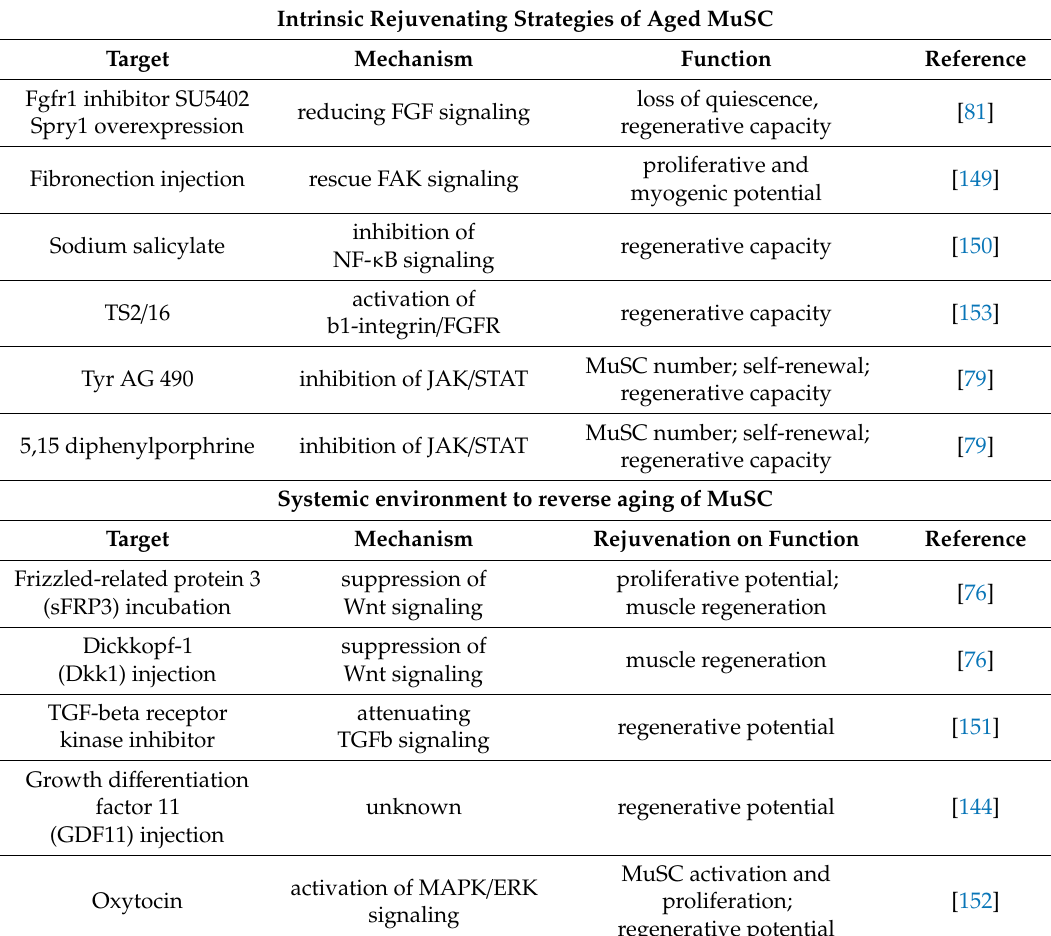
Table 1. Non-cell autonomous rejuvenation strategies of aged